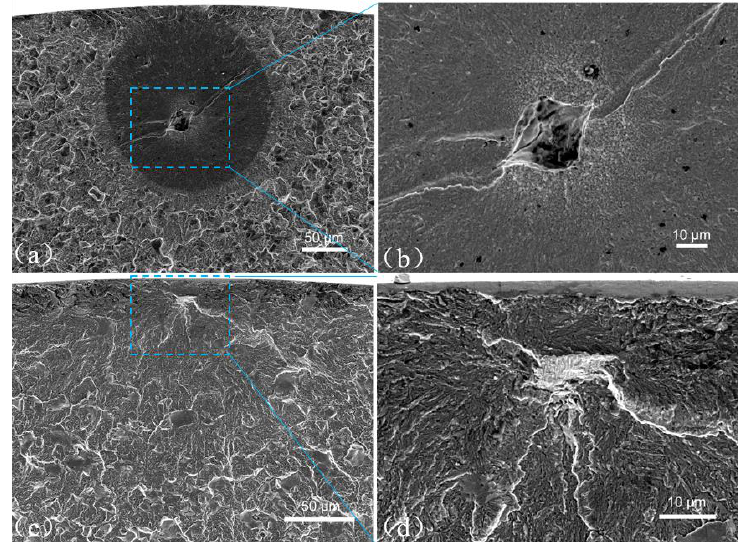
Figure 3. SEM photos for TT 200 by RB. ( a ) A1, σ max = 850 MPa, N f = 3.3 × 10 7 ; ( b ) enlargement of crack origin in a ; ( c ) A2, σ max = 900 MPa, N f = 1.5 × 10 7 ; ( d ) enlargement of crack origin in c .